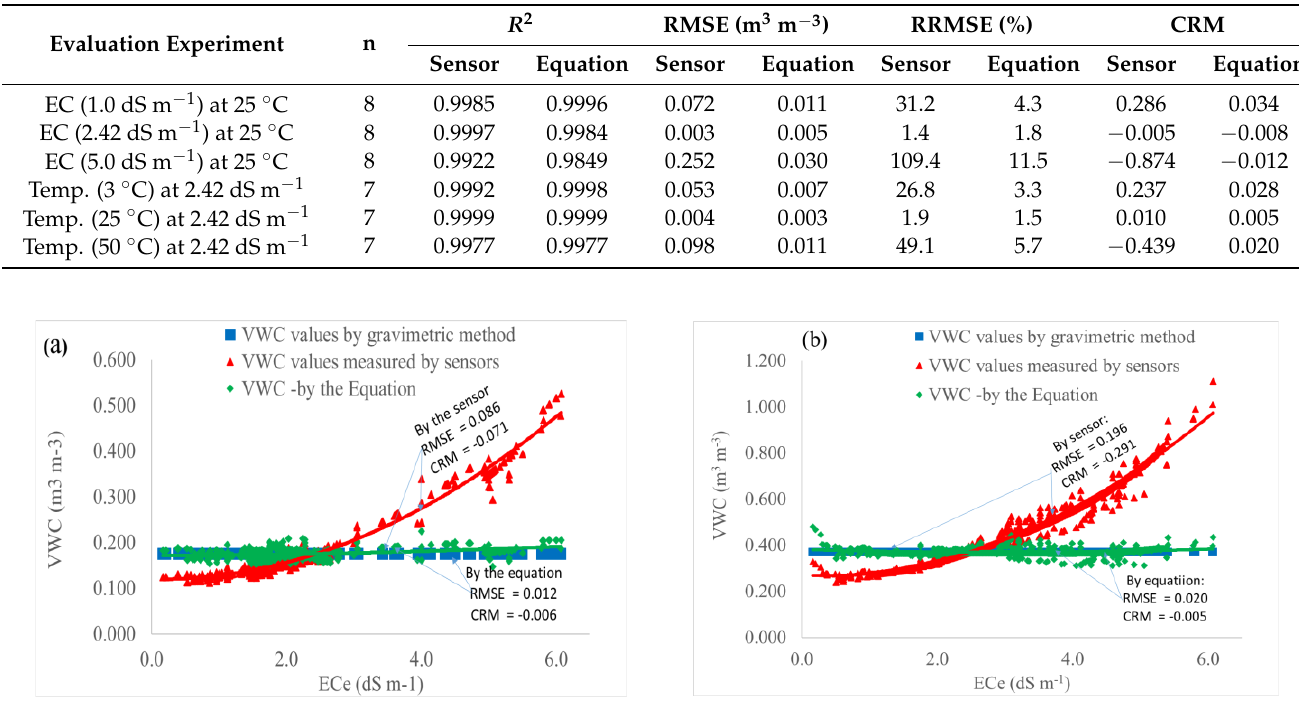
Figure 10. Comparison between VWC values measured by sensor, by gravimetric method, and by proposed L&O correction equation with a gradual increase in soil EC at 25 °C, tested at ( a ) soil moisture at field capacity and ( b ) soil moisture at saturated point.